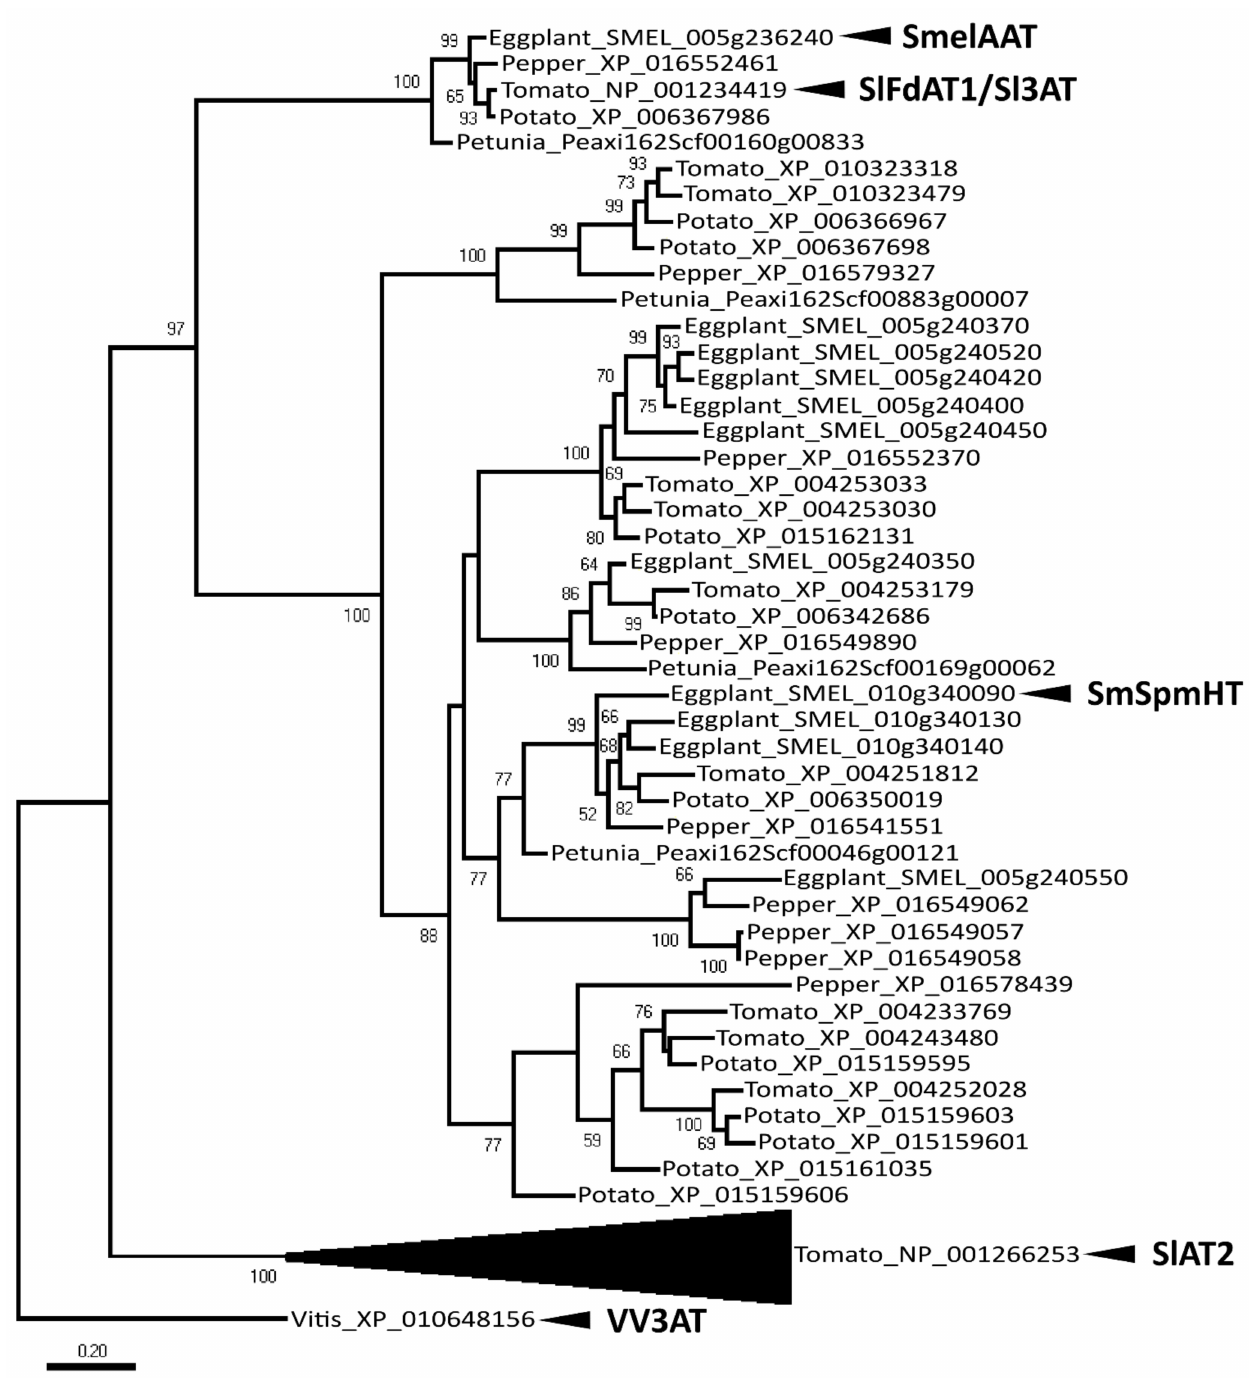
Figure 2. Evolutionary relationships among acyltransferase proteins in different plant species. The tree was obtained using peptide sequences from S. melongena (Eggplant), S. lycopersicum (Tomato), S. tuberosum (Potato), C. annuum (Pepper), P. axillaris (Petunia), and Vitis vinifera (Vitis). SmelAAT and other acyltransferases with known function from the literature (SlAT2, SmSpmHT, SlFdAT1/Sl3AT) are indicated next to the corresponding sequences. A previously described V. vinifera sequence (corresponding to Vv3AT) was included as the outgroup. A subtree comprising the 32 most distantly related sequences to SmelAAT was compressed for clarity. Only bootstrap values >50 are